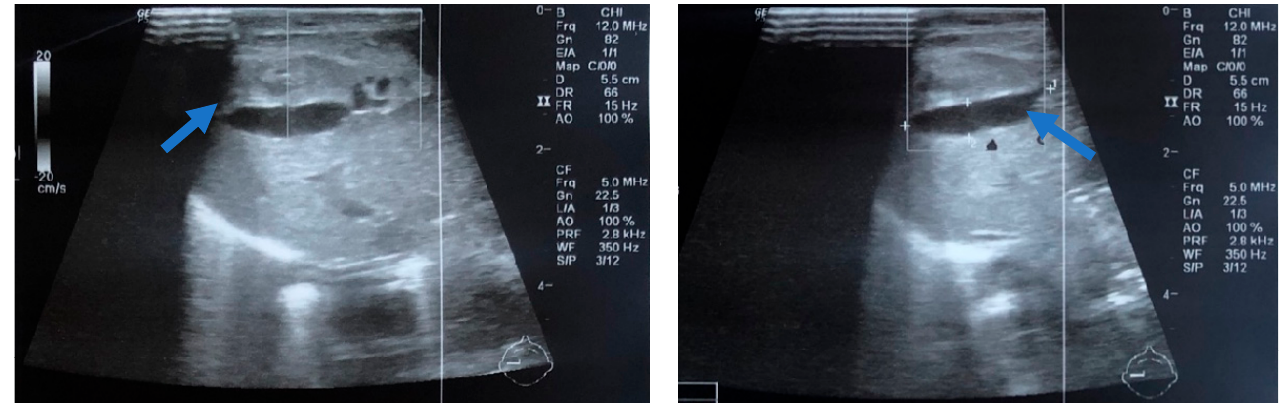
Figure 2. Abdominal ultrasonography depicting a cystic formation 2.1 cm × 0.5 cm in the anterior portion of the right liver, with anechoic characteristics (blue arrow).